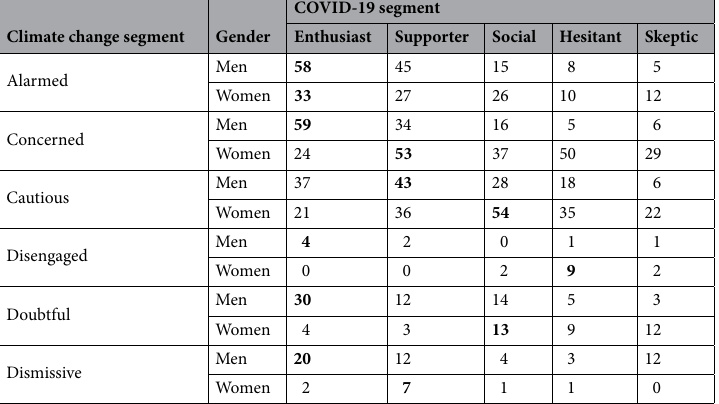
Table 5. Number of men and women respondents within each combination of COVID-19 vaccine and climate change segments. Bold values contain the largest vaccine segment membership (the mode value) within each climate change segment.